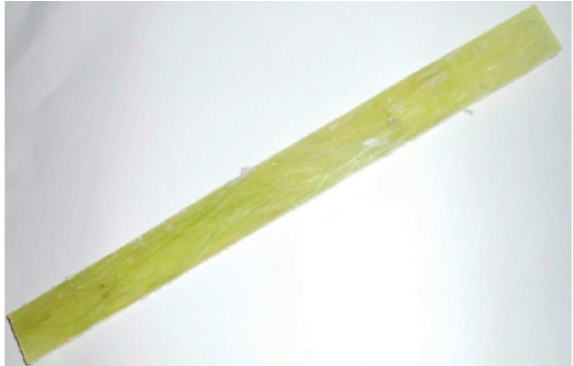
Figure 9: Specimen for flexural test.